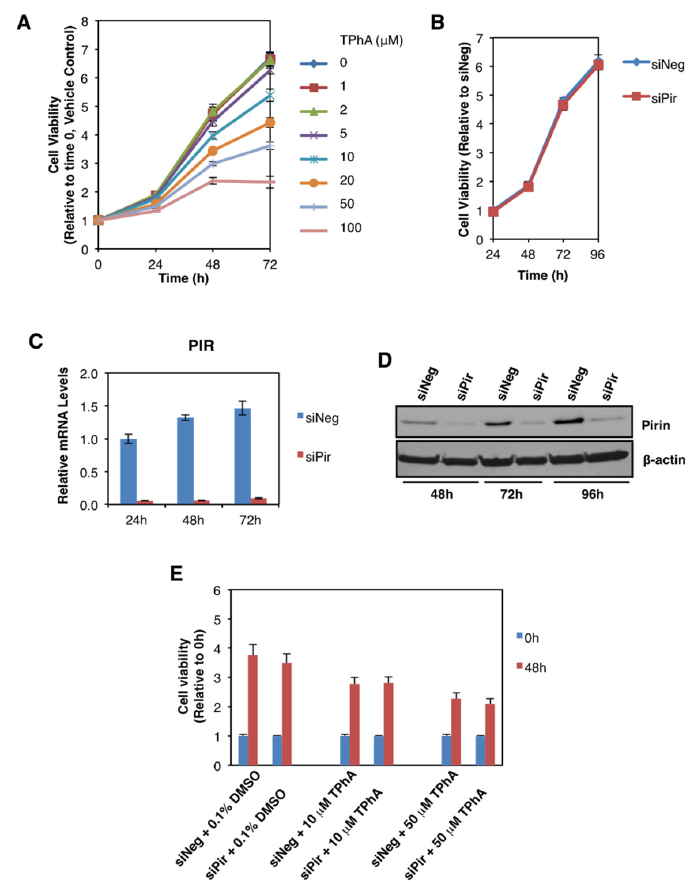
Figure 5. Pirin does not affect the viability of DLD1 colorectal cancer cells. ( A ) DLD1 cells (5 × 10 3 per well) plated in 96-well plates were treated with the indicated concentration of TphA for 24-, 48- and 72 h. Cell viability was assessed using the Alamar Blue fluorometric assay. ( B ) DLD1 cells (5 × 10 3 per well) were transfected with 20 nM ON-TARGET plus Smart Pool siRNA against human PIR (siPir) or ON-TARGET plus Non-targeting Control Pool (siNeg). Cell viability was monitored for four days after transfection with Alamar Blue reagent. ( C ) mRNA levels for pirin in DLD1 cells transfected with 20 nM siNeg or siPir for 24-, 48- and 72 h. ( D ) Protein levels for pirin in DLD1 cells transfected with 20 nM siNeg or siPir for 48-, 72- and 96 h. ( E ) DLD1 cells (5 × 10 3 per well) were transfected with 20 nM siNeg or siPir for 48 h, and then treated with 0.1% DMSO, 10 µ M or 50 µ M TPhA. Cell viability was assessed using the Alamar Blue fluorometric assay at 0- and 48 h after